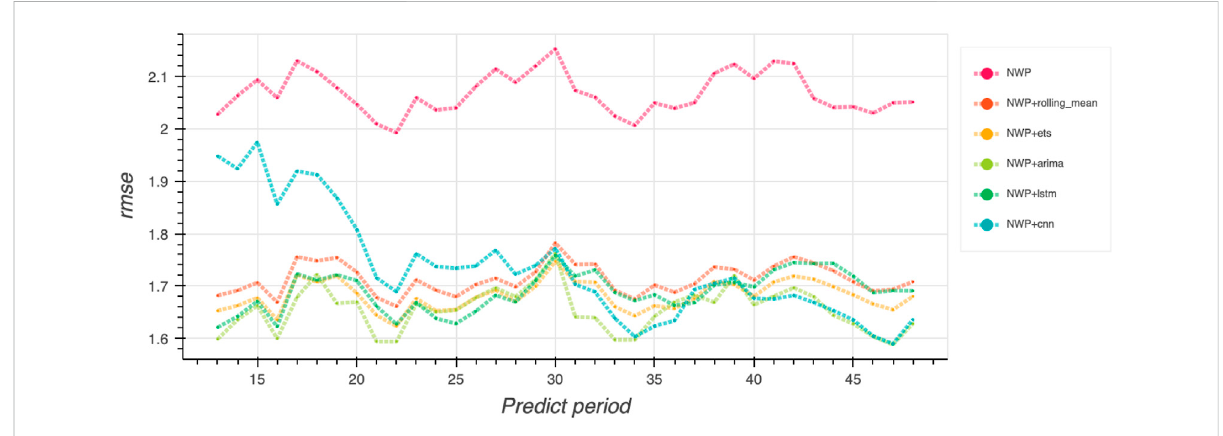
FIGURE 7 Overall rmse results based on the prediction period.